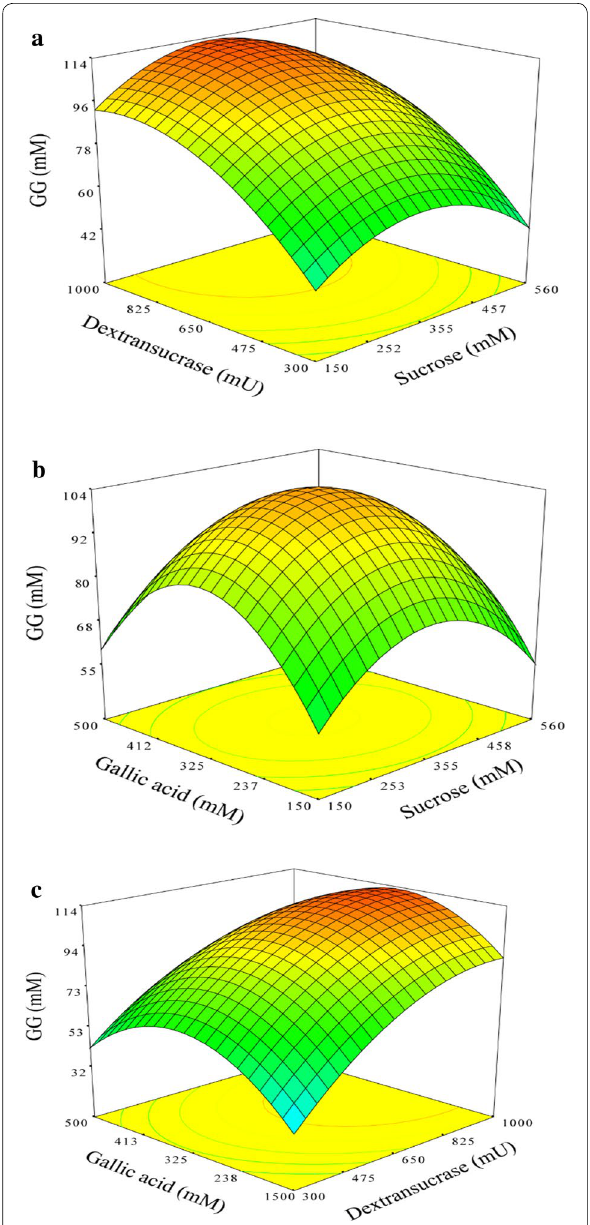
Fig. 2 The response surface and contour plots of gallic acid glyco‑ side (GG) production. The mutual interactions are shown between dextransucrase and sucrose ( a ), gallic acid and sucrose ( b ), and gallic acid and dextransucrase ( c ). The synthesis of gallic acid glycoside was optimized by dextransucrase from L. mesenteroides (61–1238 mU/mL), sucrose concentration (10–700 mM), and gallic acid